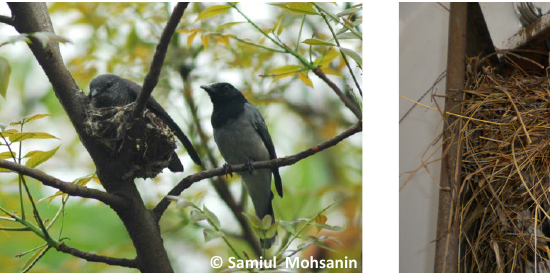
Image 14. Black-headed Cuckooshrike with nets